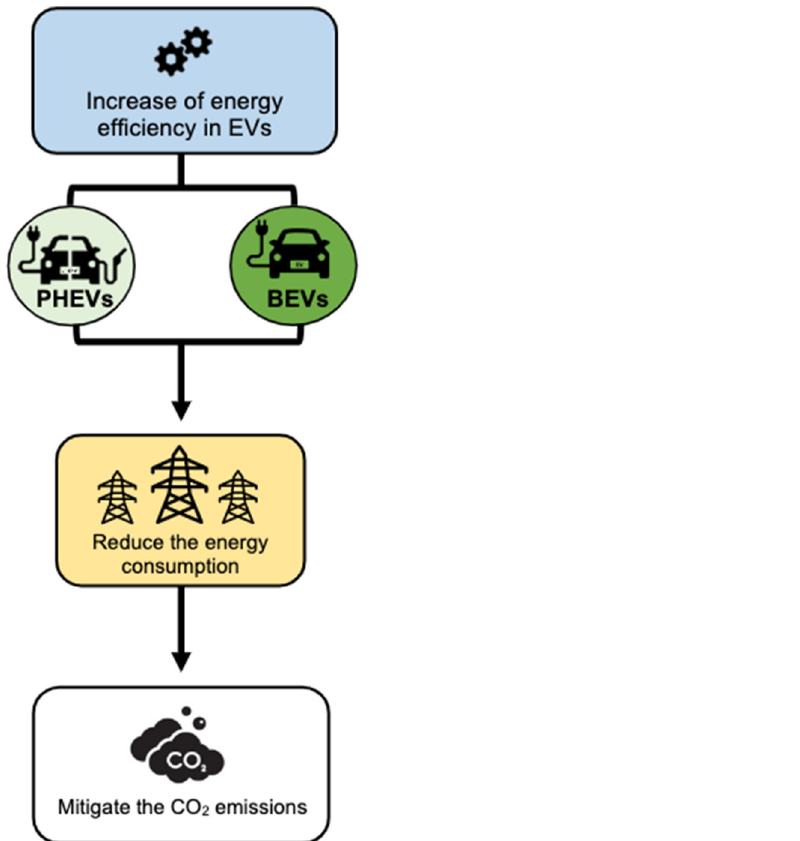
Figure 8. Summary of the effects. The authors created this figure.